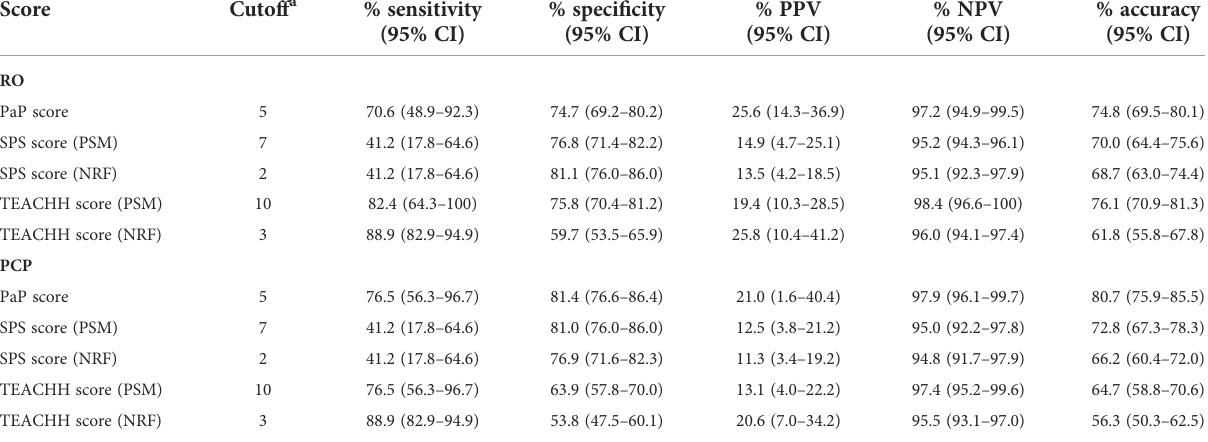
TABLE 4 Accuracy of